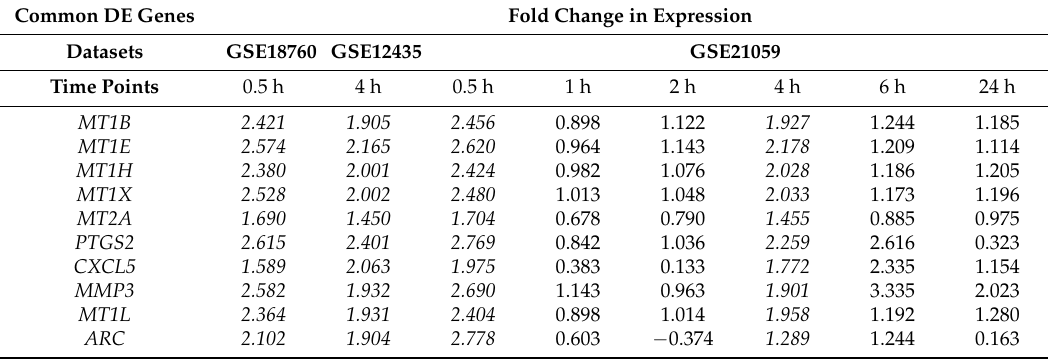
Table 2. The expression alterations of the 26 common DE genes. Values represent expression fold changes of bystander vs. control cells, on a Log2 scale. Values with bold and bold/italics illustrate similarity between the same time points of different datasets.